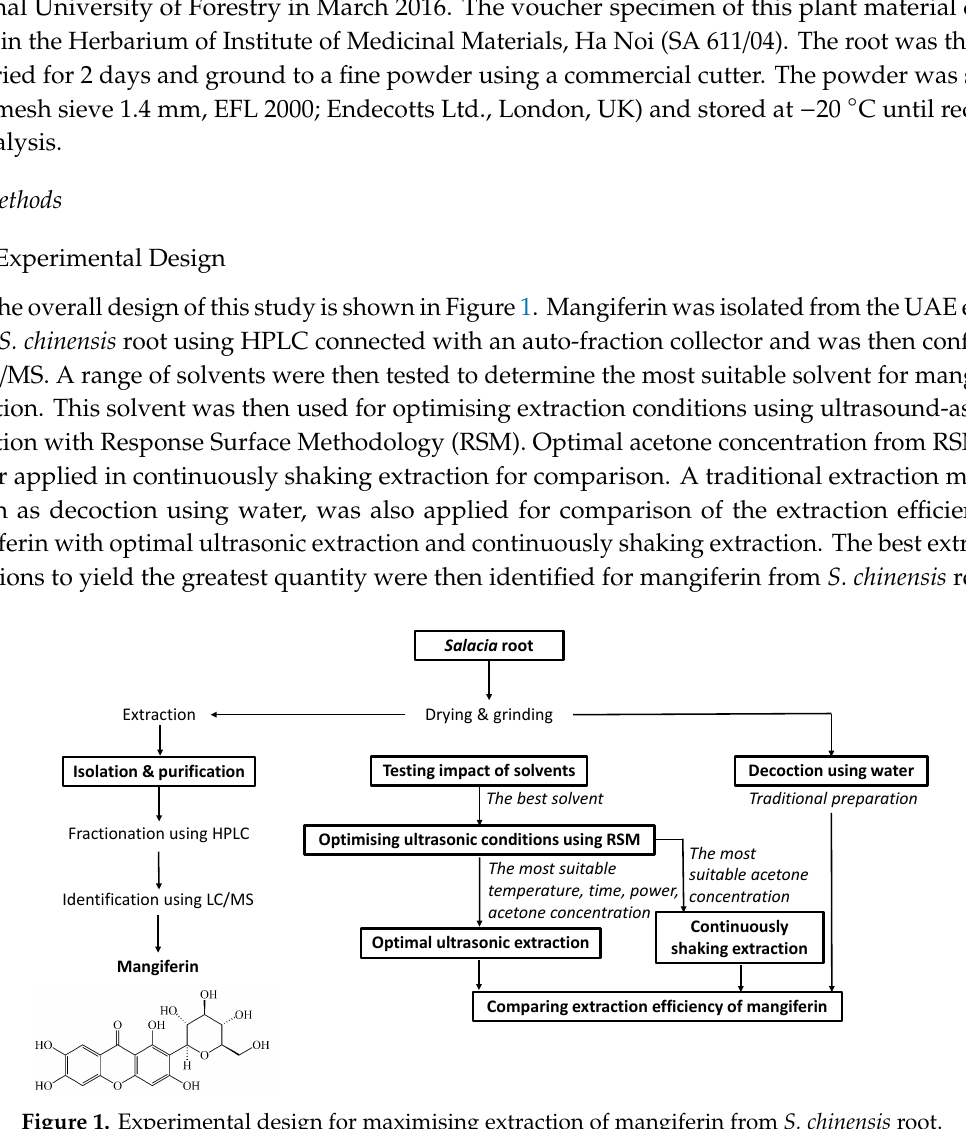
Figure 1. Experimental design for maximising extraction of mangiferin from S. chinensis